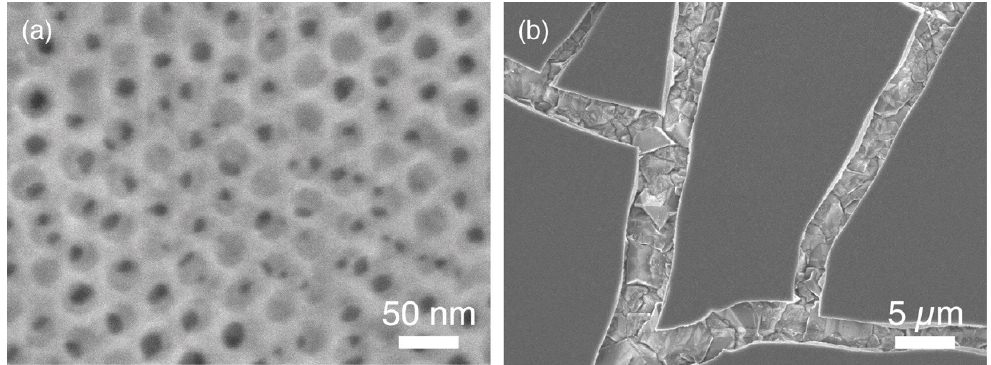
Figure 1. ( a ) High-magnification and ( b ) low-magnification top-view SEM images of the synthesized mesoporous TiO 2 thin film on the boron doped diamond (BDD) layer.